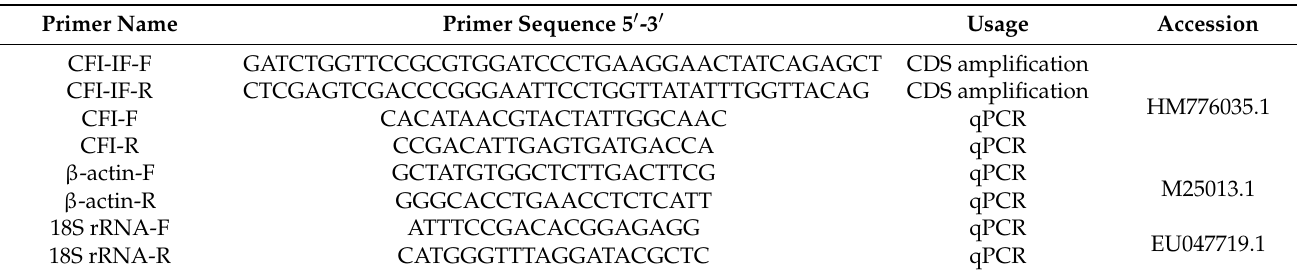
Table 2. Description of primers used in this